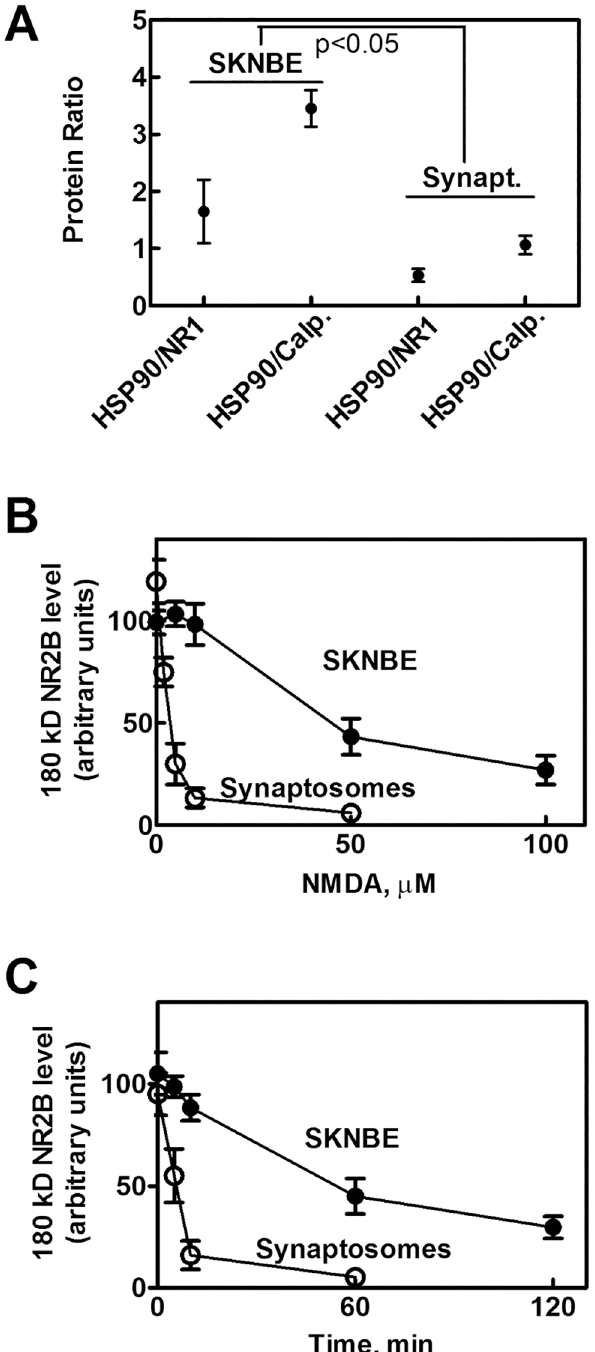
Fig 7. HSP90 levels and 180 kD NR2B degradation in rat hippocampal synaptosomes. (A) The immunoreactive bands (corresponding to HSP90, NR1 subunit, and Calpain 1) obtained by immunoprecipitation fromSKNBE cells (see Fig 1Aand relevant legend) and rat hippocampal synaptosomes (seeFig6A and relevant legend) were quantified and the indicated protein ratiowere calculated. Thevalues reportedare the arithmetical mean ± SEM of four different experiments. * p < 0.05, according to ANOVA followedby post-hoc Tukey ’ s test. (B) Quantification of the immunoreactive bands corresponding to 180 kD NR2Bsubunit immunoprecipitatedfrom theindicatedsamples incubated for 2 hours at different concentrations of NMDA. (C) Quantification of theimmunoreactive bands correspondingto 180 kD NR2B subunit immunoprecipitated from the indicatedsamples incubated with 100 μ M NMDA at different times. The values reported are the arithmetical mean ± SEM of three different experiments.